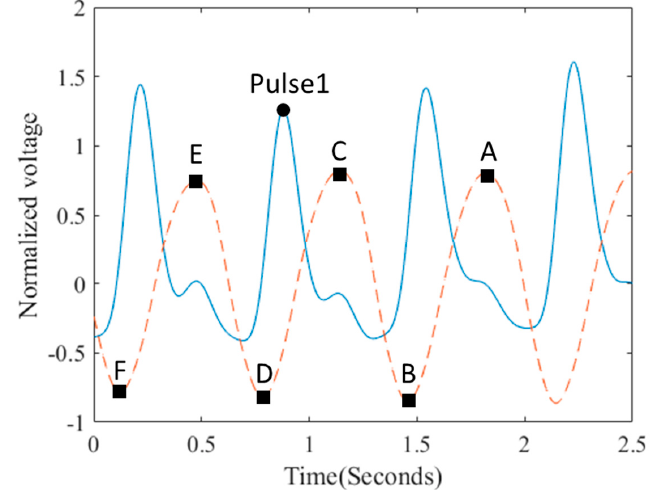
Figure 3. Smoothed PPG signal (dash line) is obtained by filtering the PPG signal (solid line) with a Gaussian filter.